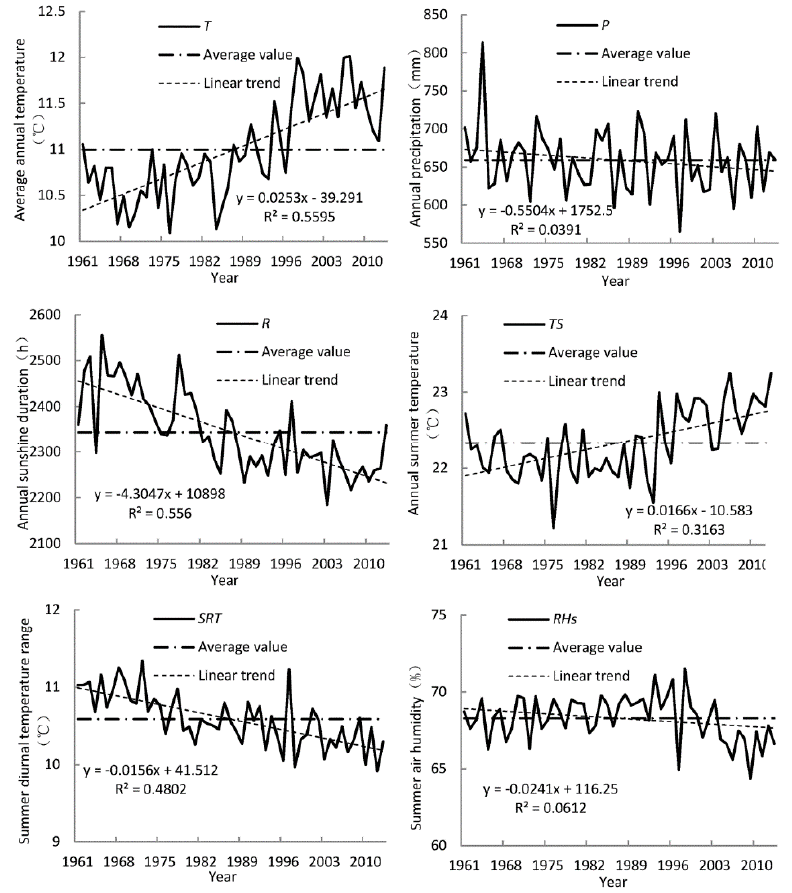
Figure 2. Annual variations of the major climate factors affecting apple quality in the main apple-producing regions of